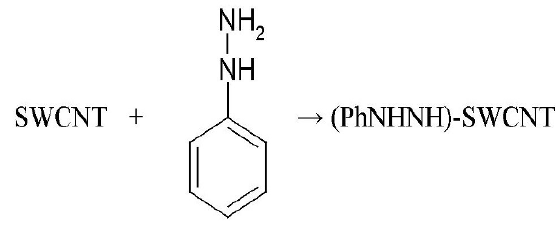
Figure 1. Reaction of SWCNTs with